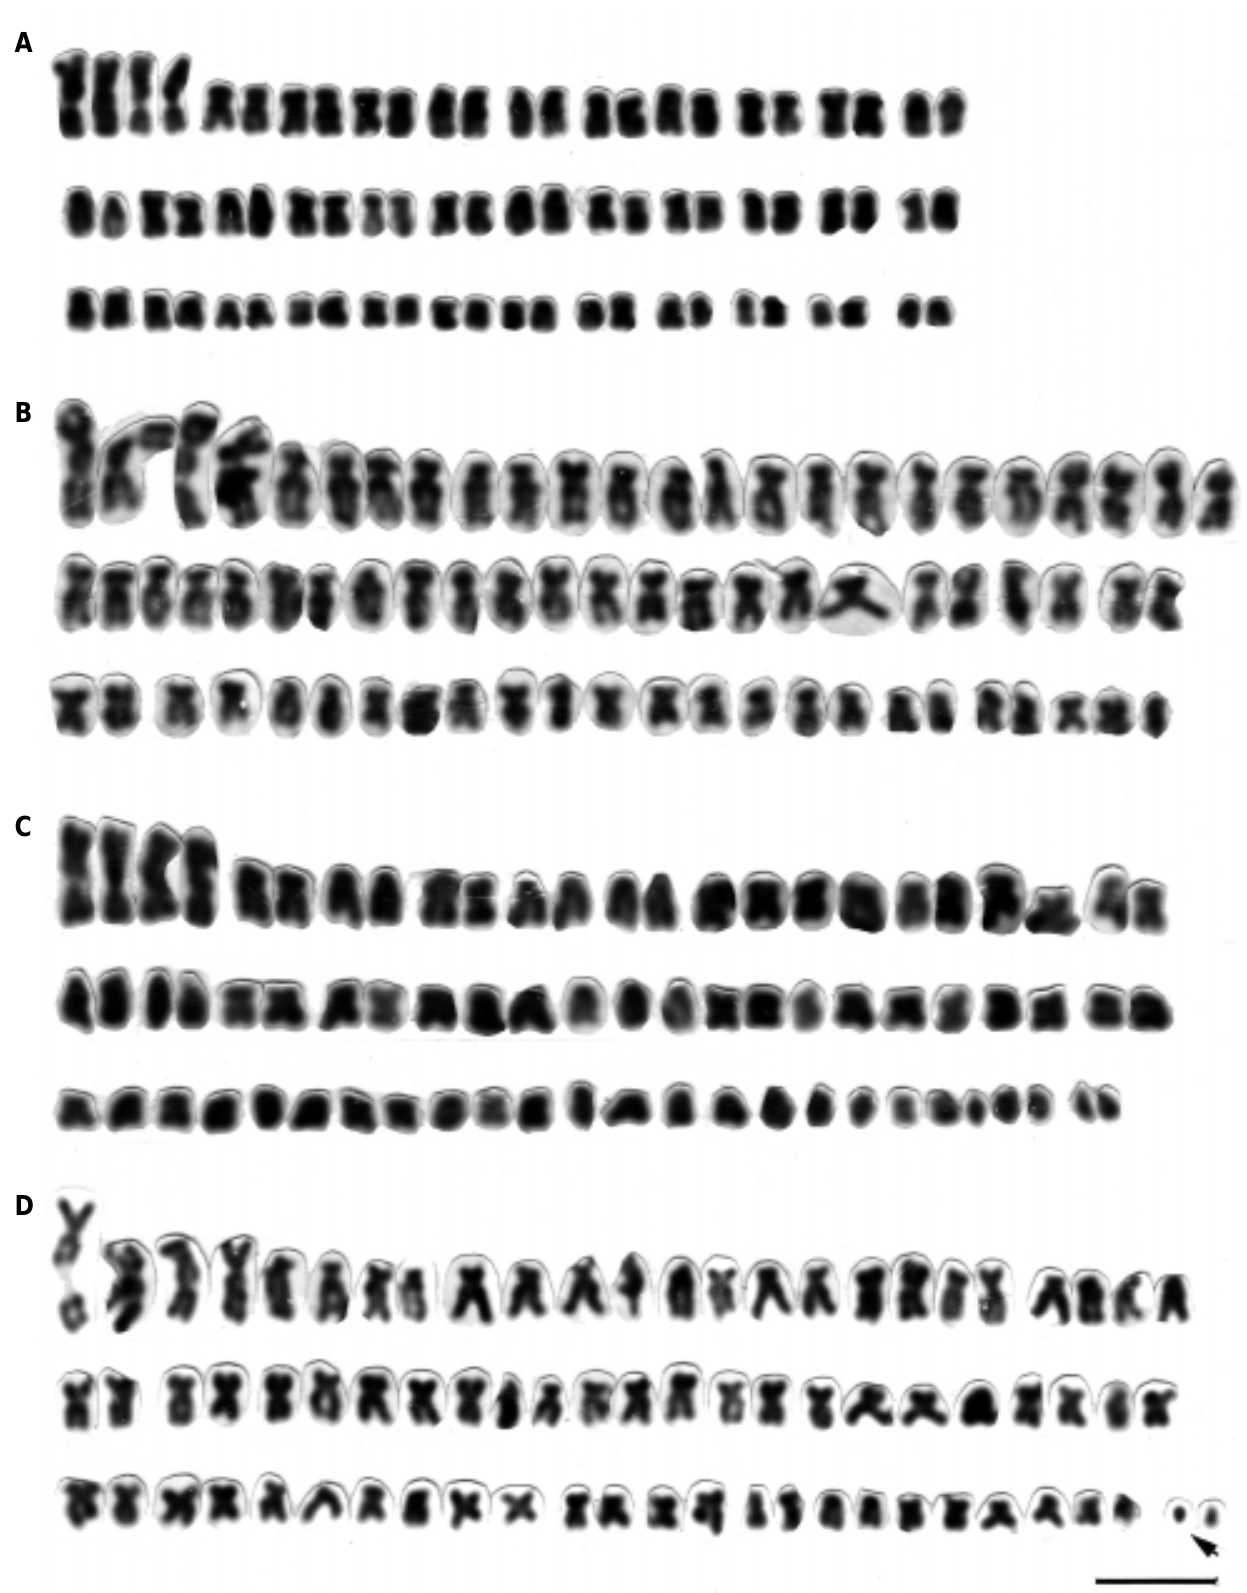
Figure 2 - Karyotypes of four tetraploid cytotypes of Mikania micrantha including the populations from: A. Foz do Iguaçu, B. Guaíba, C. Tamarana, D. Apucarana. Bar = 4 m m. Arrowhead indicates